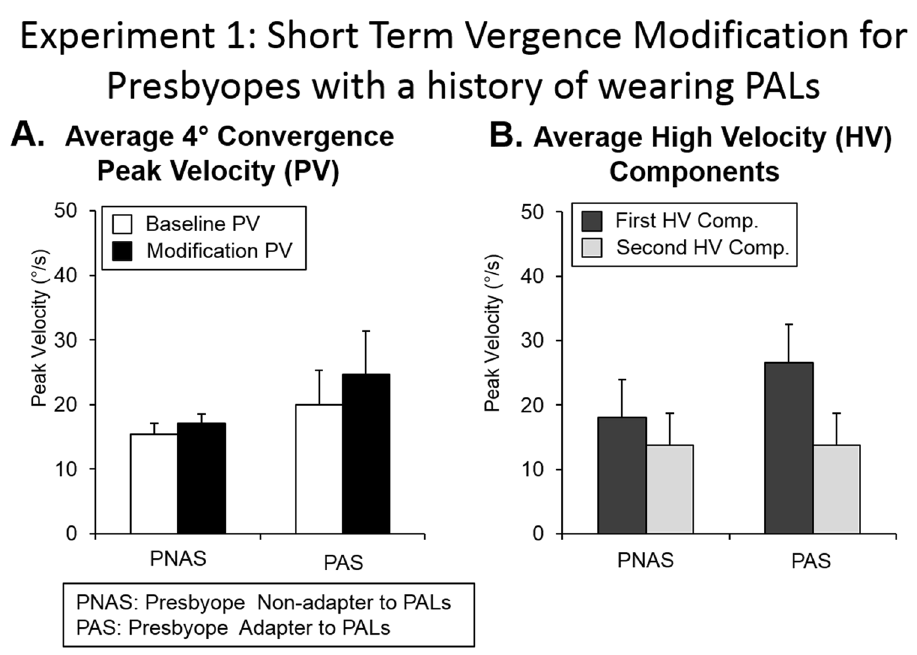
Figure 3. Summary of the average peak velocity (°/s) with one standard deviation of ( A ) 4° convergence steps during baseline and modification phases ( B ) first and second high-velocity components during the modification phase. Individual subject data from eight subjects who did not adapt to PALs (PNAS) and eight subjects who did adapt to PALs (PAS) were averaged.